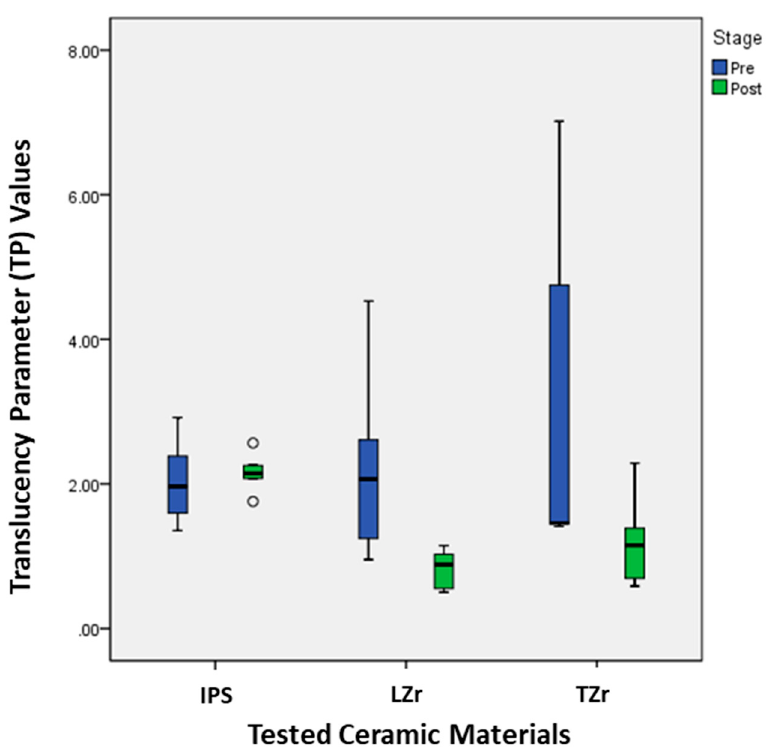
Figure 3. Comparison between the pre- and post-bleaching values of translucency parameter (TP) for the three tested materials (IPS, LZr, and TZr).